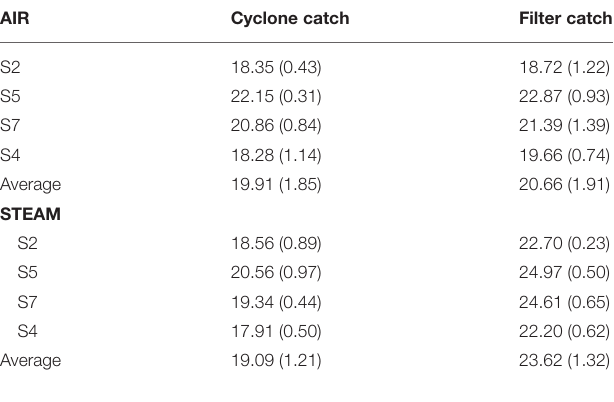
TABLE 4 | Higher heating value at constant volume (HHV) of cyclone (ACC) and filter catch (AFC) materials in MJ kg − 1 (standard deviations from duplicate runs in parentheses).